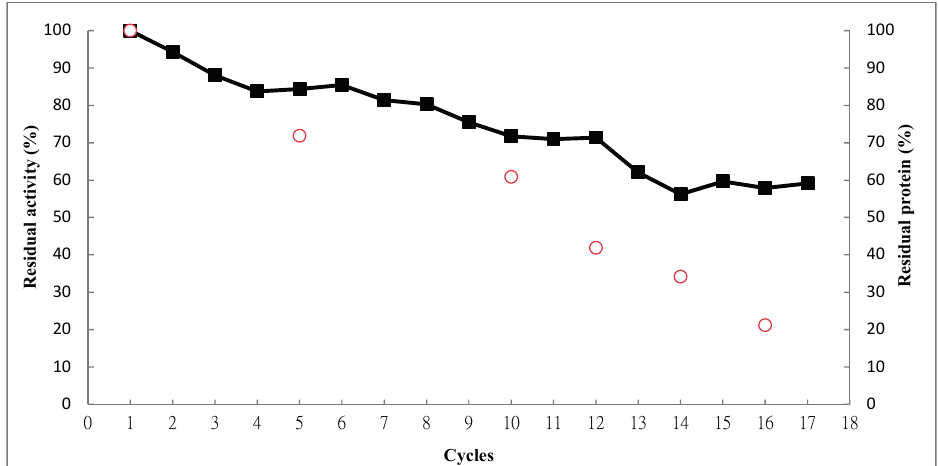
Figure 5. Reusability of the immobilized enzyme. Residual activity of the immobilized enzyme ( ■ ) and the amount of residual proteins ( ○ ) from the adsorbents were carried out at room temperature in a reaction buffer containing 100 μ M Chl a for 30 min.